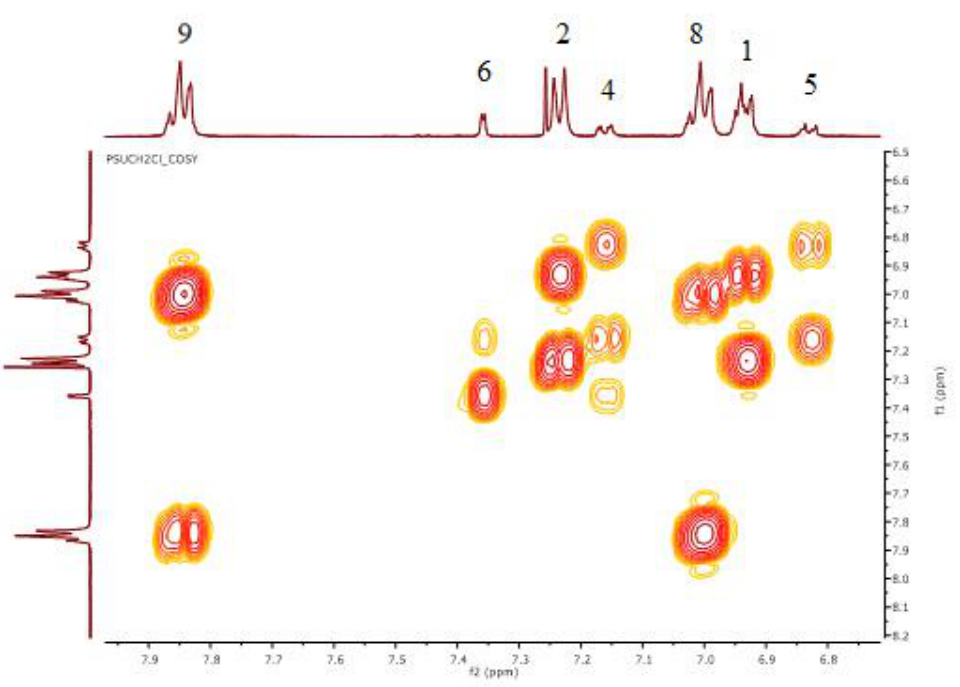
Figure 2. COSY – NMR of 50% chloromethylated PSU.